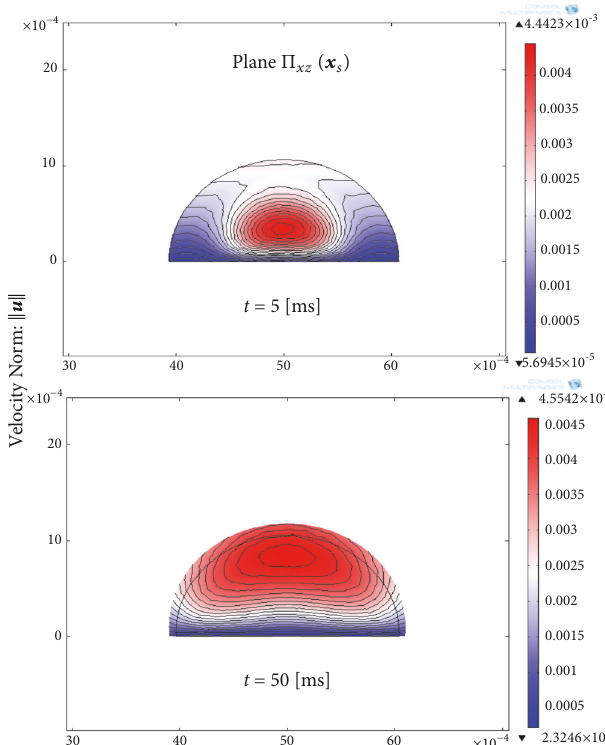
Figure 11: Two-dimensional plots of the velocity norm ‖ u ‖ of two interacting droplets of the same radius 𝑅 1 = 𝑅 2 on the plane Π 𝑥𝑧 ( x 𝑠 ) at times 𝑡 = 5 , 50 [ms]. The solid lines stand for the iso- ‖ u ‖ contours.